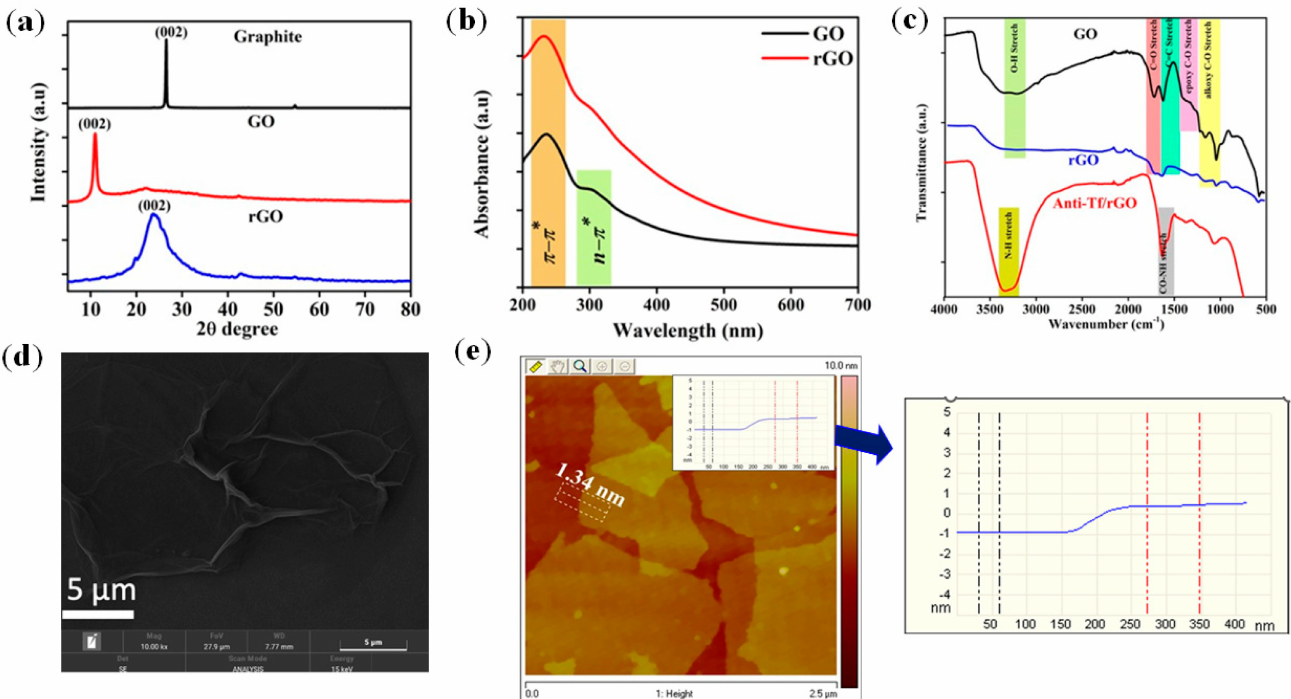
Figure 1. ( a ) X − ray diffraction pattern of GO, graphite, and rGO; ( b ) UV − Visible spectra of prepared GO and rGO; ( c ) FTIR spectroscopy of GO, anti − Tf/rGO, and rGO; ( d ) SEM image of GO; ( e ) AFM image of